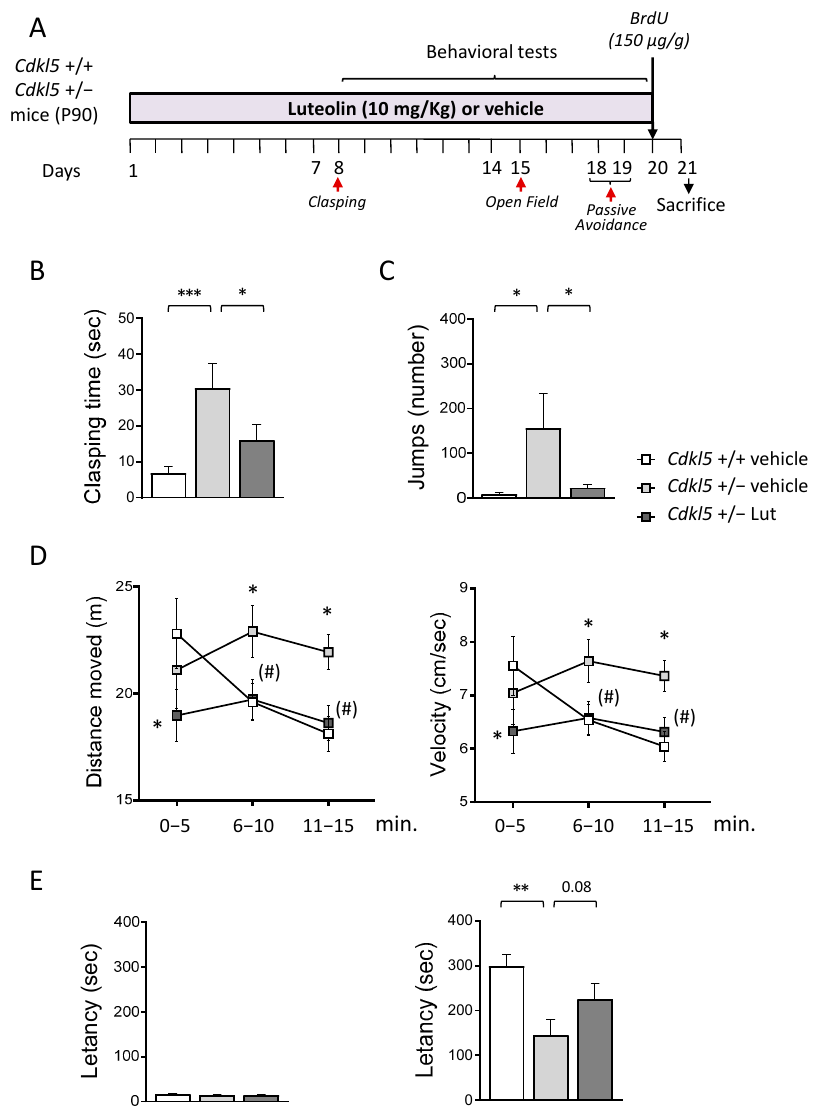
Figure 1. Effect of luteolin treatment on behavior of Cdkl 5 +/ − mice. ( A ) Experimental plan. Starting from postnatal day 90 (P90), Cdkl 5 +/ − female mice were treated with vehicle or luteolin (i.p. 10 mg/kg) for 20 days. Behavioral tests were performed during the last two weeks of treatment. Red arrows indicate the day on which the behavioral tests were performed. The day before sacrificed mice received a single subcutaneous injection of bromodeoxyuridine (BrdU 150 µg/g). ( B ) Total amount of time spent hind-limb clasping during a 2-min interval in vehicle-treated Cdkl 5 +/+ (n = 21) and Cdkl 5 +/ − (n = 18) mice and luteolin-treated Cdkl 5 +/ − (n = 18) mice. ( C ) Number of stereotypic jumps (repetitive beam breaks < 1 s) in the corners of the open field arena during the 15-min trial in vehicle-treated Cdkl 5 +/+ (n = 19) and Cdkl 5 +/ − (n = 18) mice and luteolin-treated Cdkl 5 +/ − (n = 17) mice. ( D ) Locomotor activity measured as average locomotion velocity (right graph) and total distance travelled (left graph) during a 15-min open field test in vehicle-treated Cdkl 5 +/+ (n = 19) and Cdkl 5 +/ − (n = 18) mice and luteolin-treated Cdkl 5 +/ − (n = 17) mice. ( E ) Passive avoidance test on vehicle-treated Cdkl 5 +/+ (n = 21) and Cdkl 5 +/ − (n = 18) mice and luteolin treated Cdkl 5 +/ − (n = 17) mice. Graphs show the latency to enter the dark compartment on the 1st day (on the left) and on the 2nd day (on the right) of the behavioral procedure. Values represent mean ± SEM. * p < 0.05, ** p < 0.01, *** p < 0.001 as compared to the vehicle-treated Cdkl 5 +/+ condition; (#) p < 0.065 as compared to the vehicle-treated Cdkl 5 +/ − condition. Fisher’s LSD test after one-way ANOVA for data set in ( B , C , E ) and after two-way ANOVA for data set in ( D